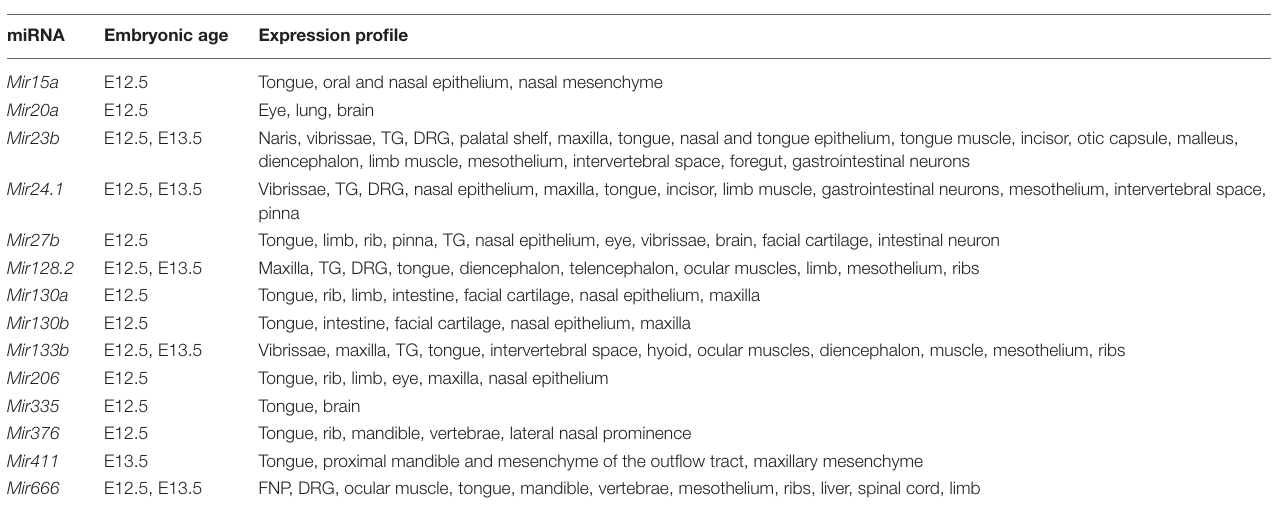
TABLE 2 | Expression profiles of miRNAs in the developing mouse